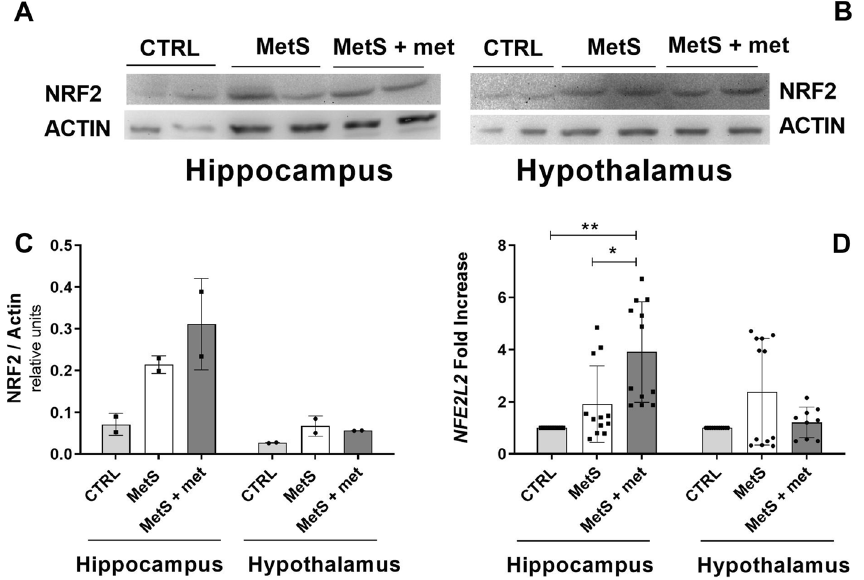
Figure 7. Effect of the metabolic syndrome (MetS) and metformin on NRF2 protein and NFE2L2 gene expression in the hippocampus and hypothalamus. ( A , B ) Representative blots showing NRF2 protein expression in the hippocampus and hypothalamus. ( C ) Densitometric analysis of NRF2 protein expression in the hippocampus and hypothalamus. ( D ) NFE2L2 gene expression in the hippocampus and hypothalamus. The data represent the mean ± SD. Sample size (N) for NRF1 protein expression CTRL = 2, MetS = 2, MetS + met = 2; hippocampal NFE2L2 gene expression CTRL = 11, MetS = 12, MetS + met = 12; hypothalamic NFE2L2 gene expression CTRL = 11, MetS = 12, MetS + met = 9. *p ≤ 0.05, **p ≤